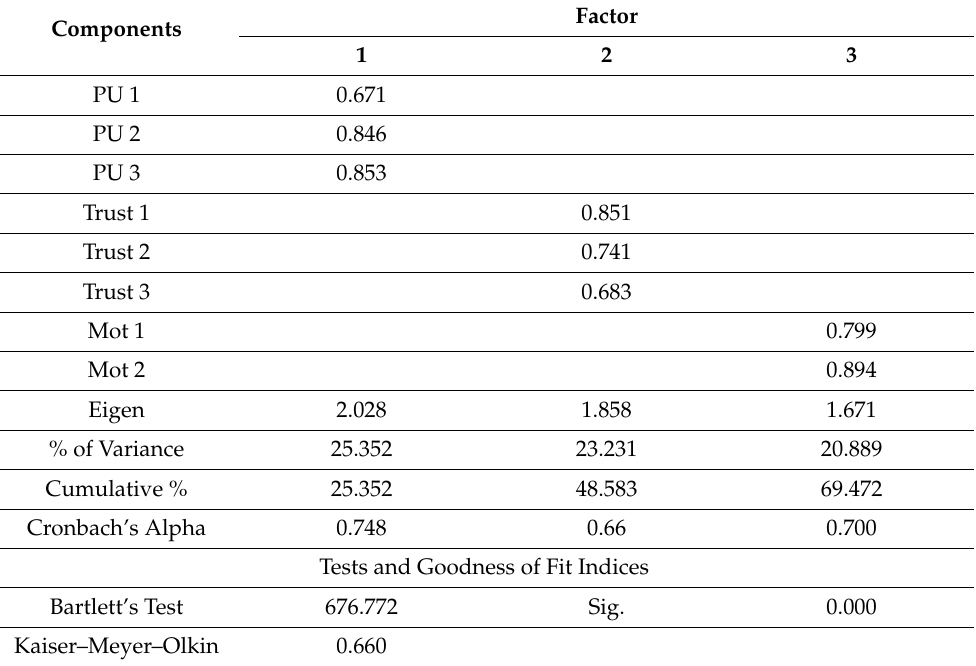
Table 3. Results of the factor analysis for the constructs of the ‘farmers’ willingness’ factor category.